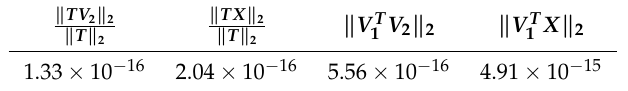
X , for Example 3. 1